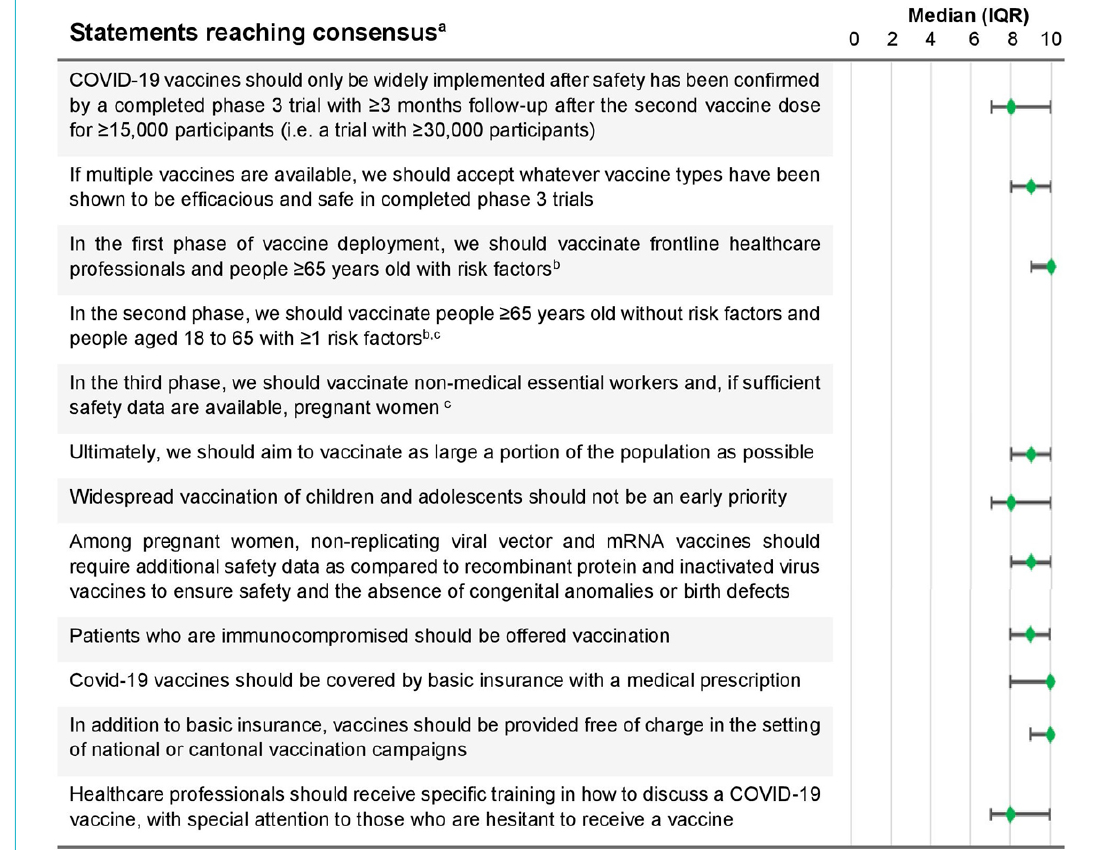
Figure 1: Key recommendation statements that reached consensus. a Agreement scores were on a scale from 0 (complete disagreement) to 10 (complete agreement). The green diamond is the median score, with horizontal bars representing the interquartile range (IQR). a Consen- sus was defined as a median agreement score of ≥8 out of 10, with a lower IQR bound ≥7 b Risk factors as defined by the Swiss Federal Of- fice of Public Health at https://www.bag.admin.ch/bag/en/home.html c Experts voted on which groups to include in the second and third phas- es: (1) people aged ≥65 years old without FOPH risk factors (78%); (2) people aged 18 to 65 with ≥1 FOPH risk factor (62%); (3) non-medical essential workers (30%); and (4) Pregnant women